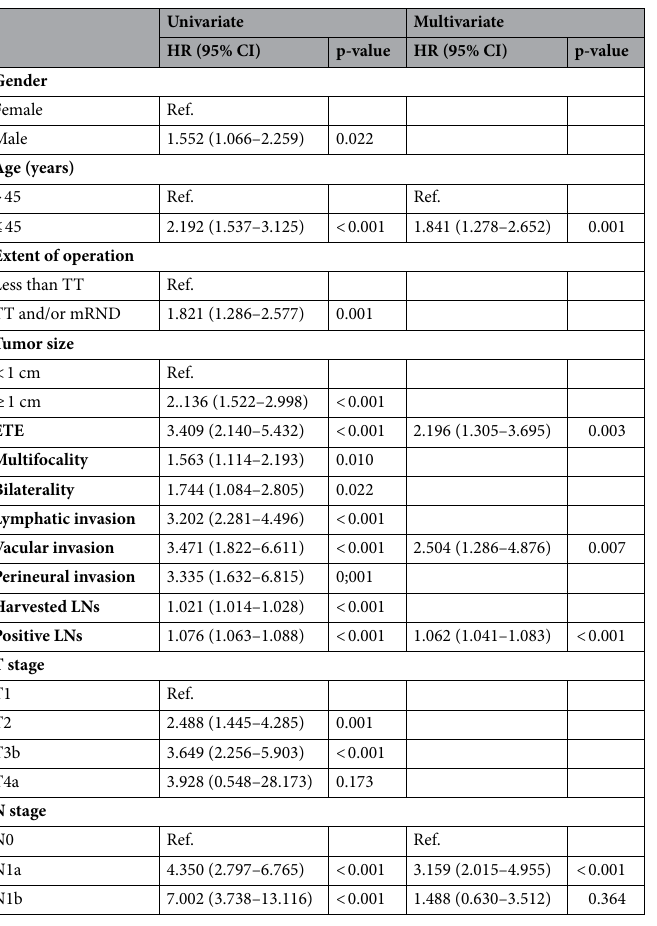
Table 2. Univariate and multivariate analyses of risk factors for recurrence before propensity score matching. Data are expressed as hazard ratio (HR) and 95% confidence interval (CI). A p value < 0.05 was considered statistically significant. TT total thyroidectomy, mRND modified radical neck dissection, ETE extrathyroidal extension, LN lymph node, T tumor, N